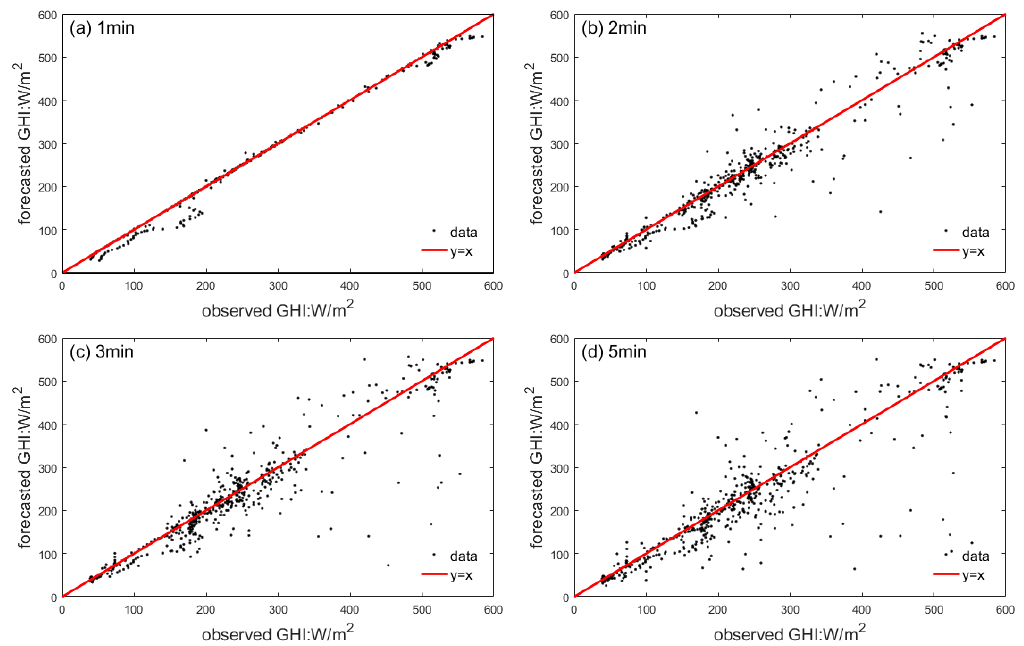
Figure 11. Scatter plots of global horizonal irradiance (GHI) forecasting based on ternary linear regression (TRL) model for 1 min ( a ), 2 min ( b ), 3 min ( c ), 5 min ( d ) on 5 November 2017.